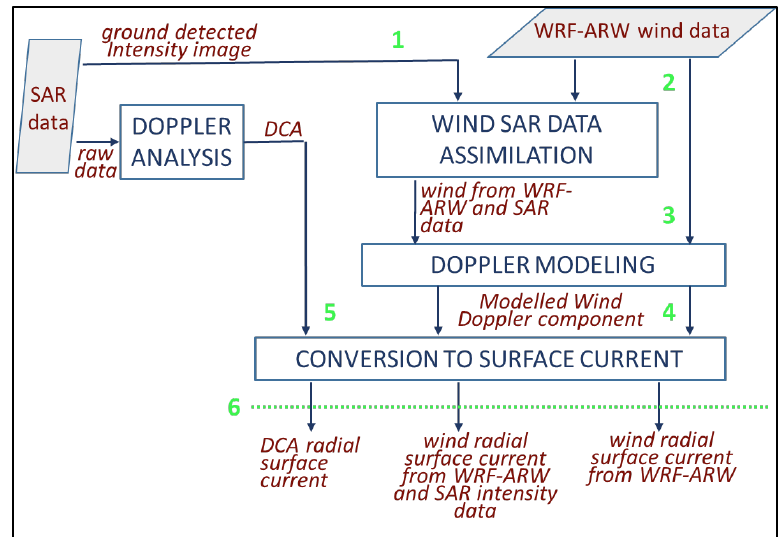
Figure 4. Data analysis scheme explaining the procedure followed for the joint analysis on the Doppler (surface current) derived by the SAR data (complex and detected intensity) and the atmospheric model.